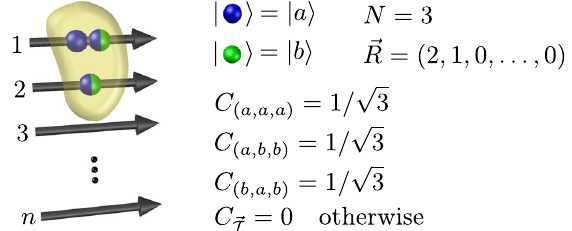
FIG. 3. Example of a state of N ¼ 3 partially distinguishable particles with mode occupation list correspondingly, mode assignment list states are depicted by black arrows, particles by colored balls, and internal states by the balls ’ coloring, with the yellow envelope illustrating correlations between the particles. Particle distin- guishability is determined by the listed coefficients C ⃗